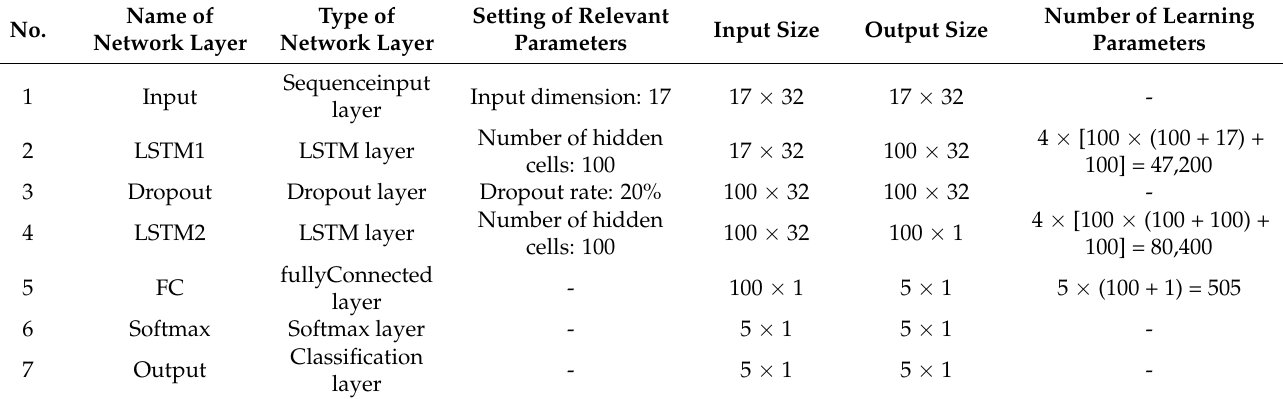
Table 8. The name of network layer and parameter settings.